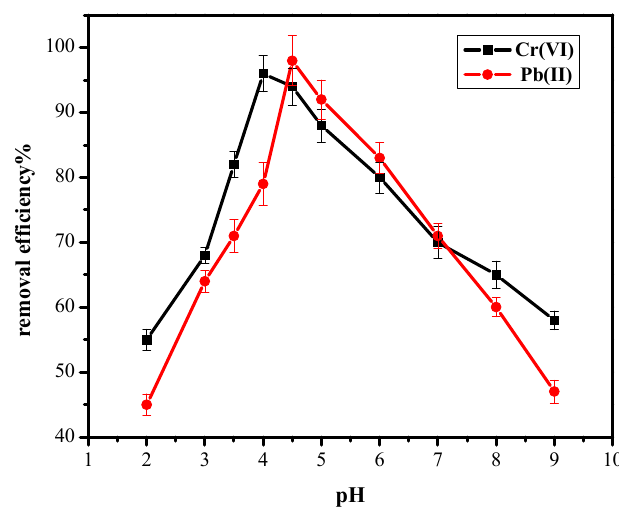
Figure 1. Effect of pH on biosorption of Pb(II) and Cr(VI) ions on AAJPL (adsorbent mass: 0.80 g/100 mL for Pb(II) and 1.00 g/100 mL for Cr(VI); metal ion concentrations: 50 mg/L for Pb(II) and 70 mg/L for Cr(VI); temperature: 25 °C).